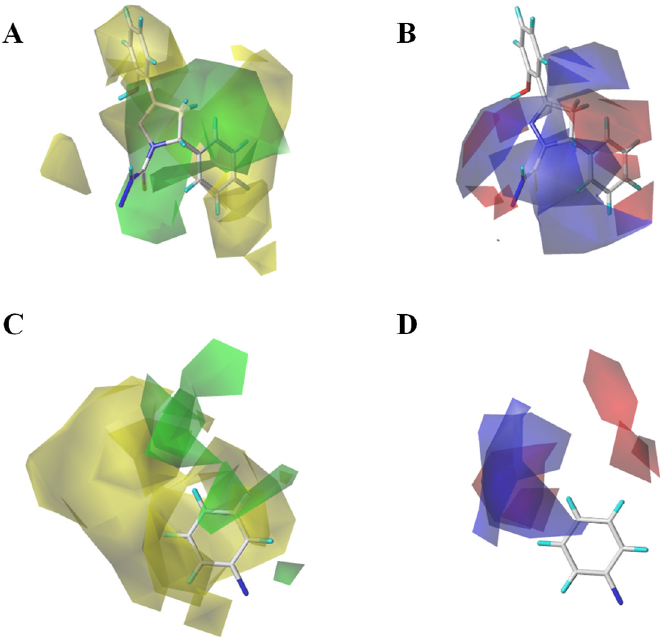
Figure 3. 3D contour maps of Topomer CoMFA Model 2 for R1 ( A , B ) and R2 ( C , D ) of compound 63. (( A , C ) represent steric contour maps. ( B , D ) represent electrostatic field maps.).